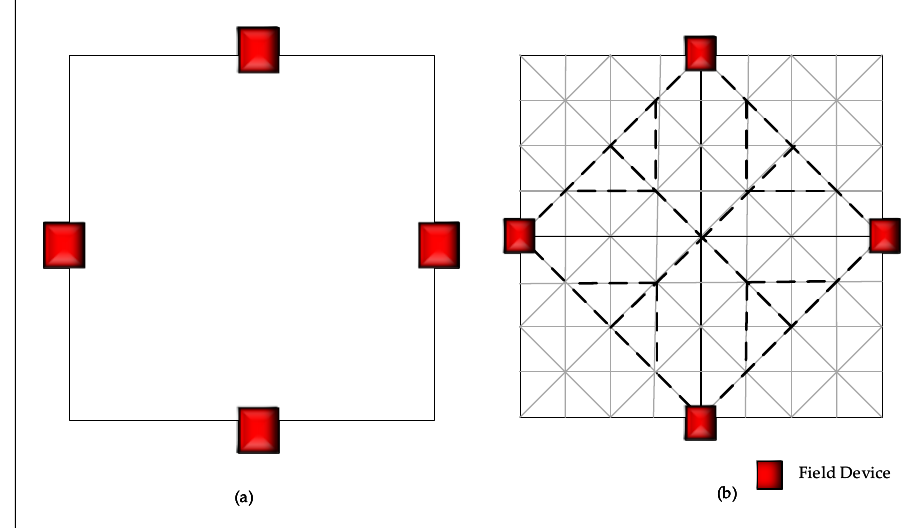
Figure 3. ( a ) Original layout of factory, ( b ) Phase 1: forming multipath triangular cells grid.